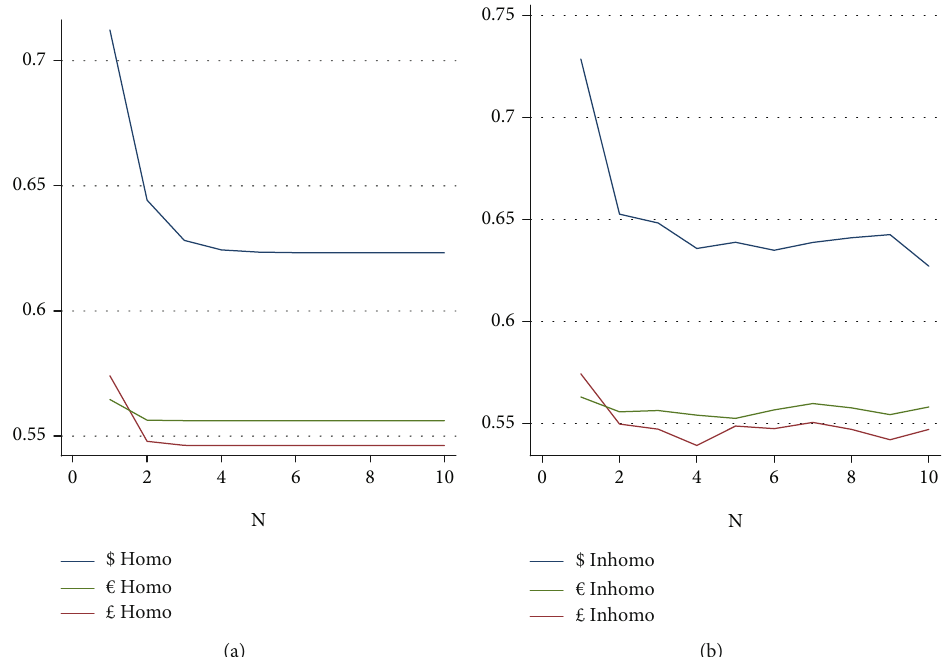
Figure 2: Plot of n -step transitional probabilities of Markov chains by homogeneity. Notes: HOMO means “ time-homogenous ” ; INHOMO means “ time-inhomogeneous. ”